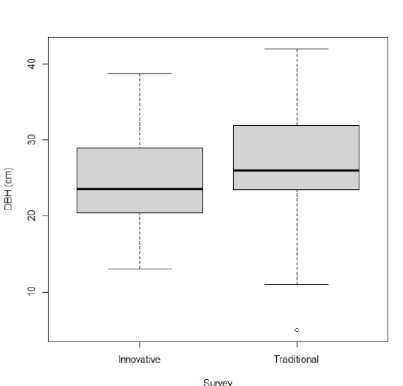
Figure 4.a Boxplots with resulting values for diameter at breast height (DBH) of plot 6-Silver Fir forest.